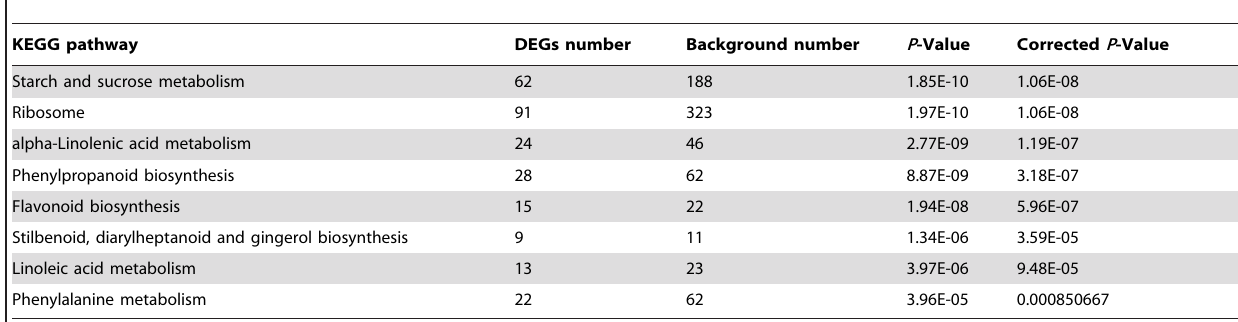
Table 4. KEGG pathways that are enriched in the defoliation-responsive DEGs compared with the reference transcriptome.